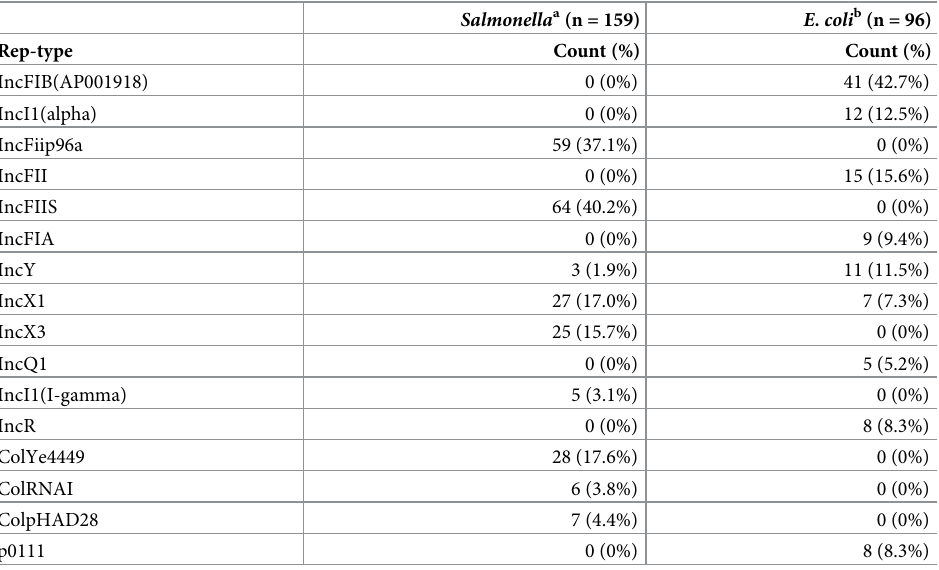
Table 3. Frequencies of plasmid incompatibility (Inc) types identified using whole-genome sequencing data